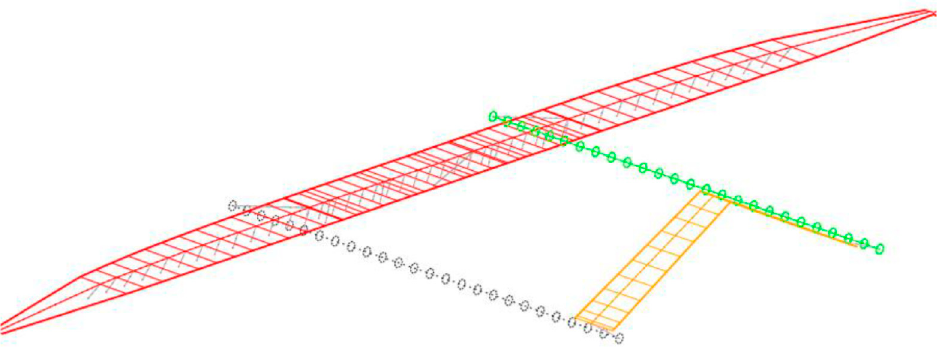
Figure 20. Geometric model used for ASWING analysis.